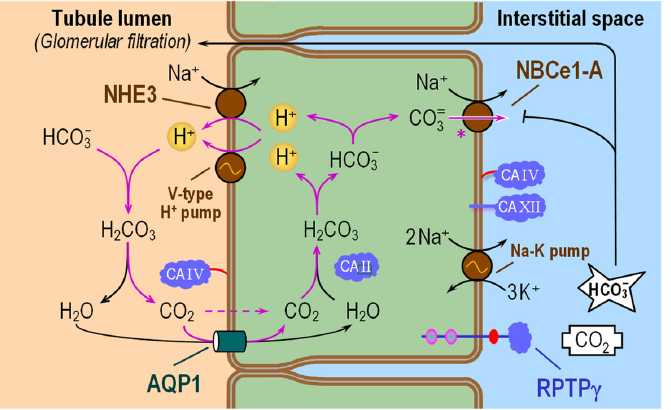
Figure 5. Cell model of HCO 3 − reabsorption in renal proximal tubule. In the lumen, filtered HCO 3 − and H + —secreted by NHE3 and V-type H + pump—react to form CO 2 and H 2 O under the catalytic action of CA IV. Apical entry of CO 2 and H 2 O via AQP1 leads to the intracellular formation of HCO 3 − and H + under the catalytic action of CA II. NBCe1-A carries CO 32 − (further ionized form of HCO 3 − ) out of the cell across the basolateral membrane. The pink symbol ‘*’ near NBCe1-A denotes uncertainty about NBCe1-A stoichiometry. For details, see text. NHE3 = Na-H exchanger 3; V-type H + pump = Vacuolar-type H + pump (or V-ATPase); AQP1 = aquaporin 1; CA II, CA IV and CA XII = carbonic anhydrase II, IV and XII; NBCe1-A = electrogenic Na/HCO 3 cotransporter (1 variant A); RPTP γ = receptor protein tyrosine phosphatase- γ